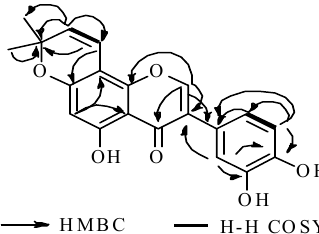
Figure 2. Partial structure of 1 solved by heteronuclear multiple-bond correlation (HMBC) and 1 H- 1 H COSY